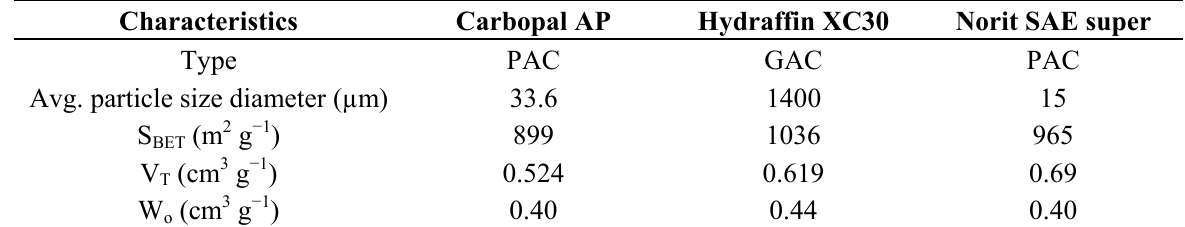
Table 3. Physical features of the used